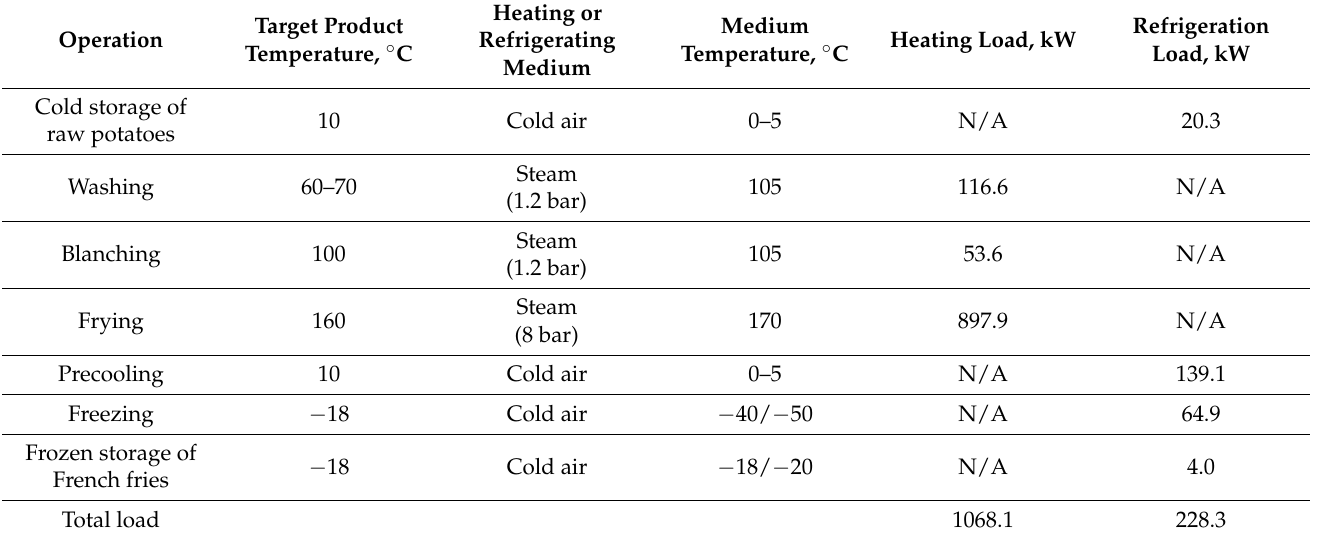
Table 2. Production line for processing and storage of frozen French fries—heating and refrigeration demands for the considered unit